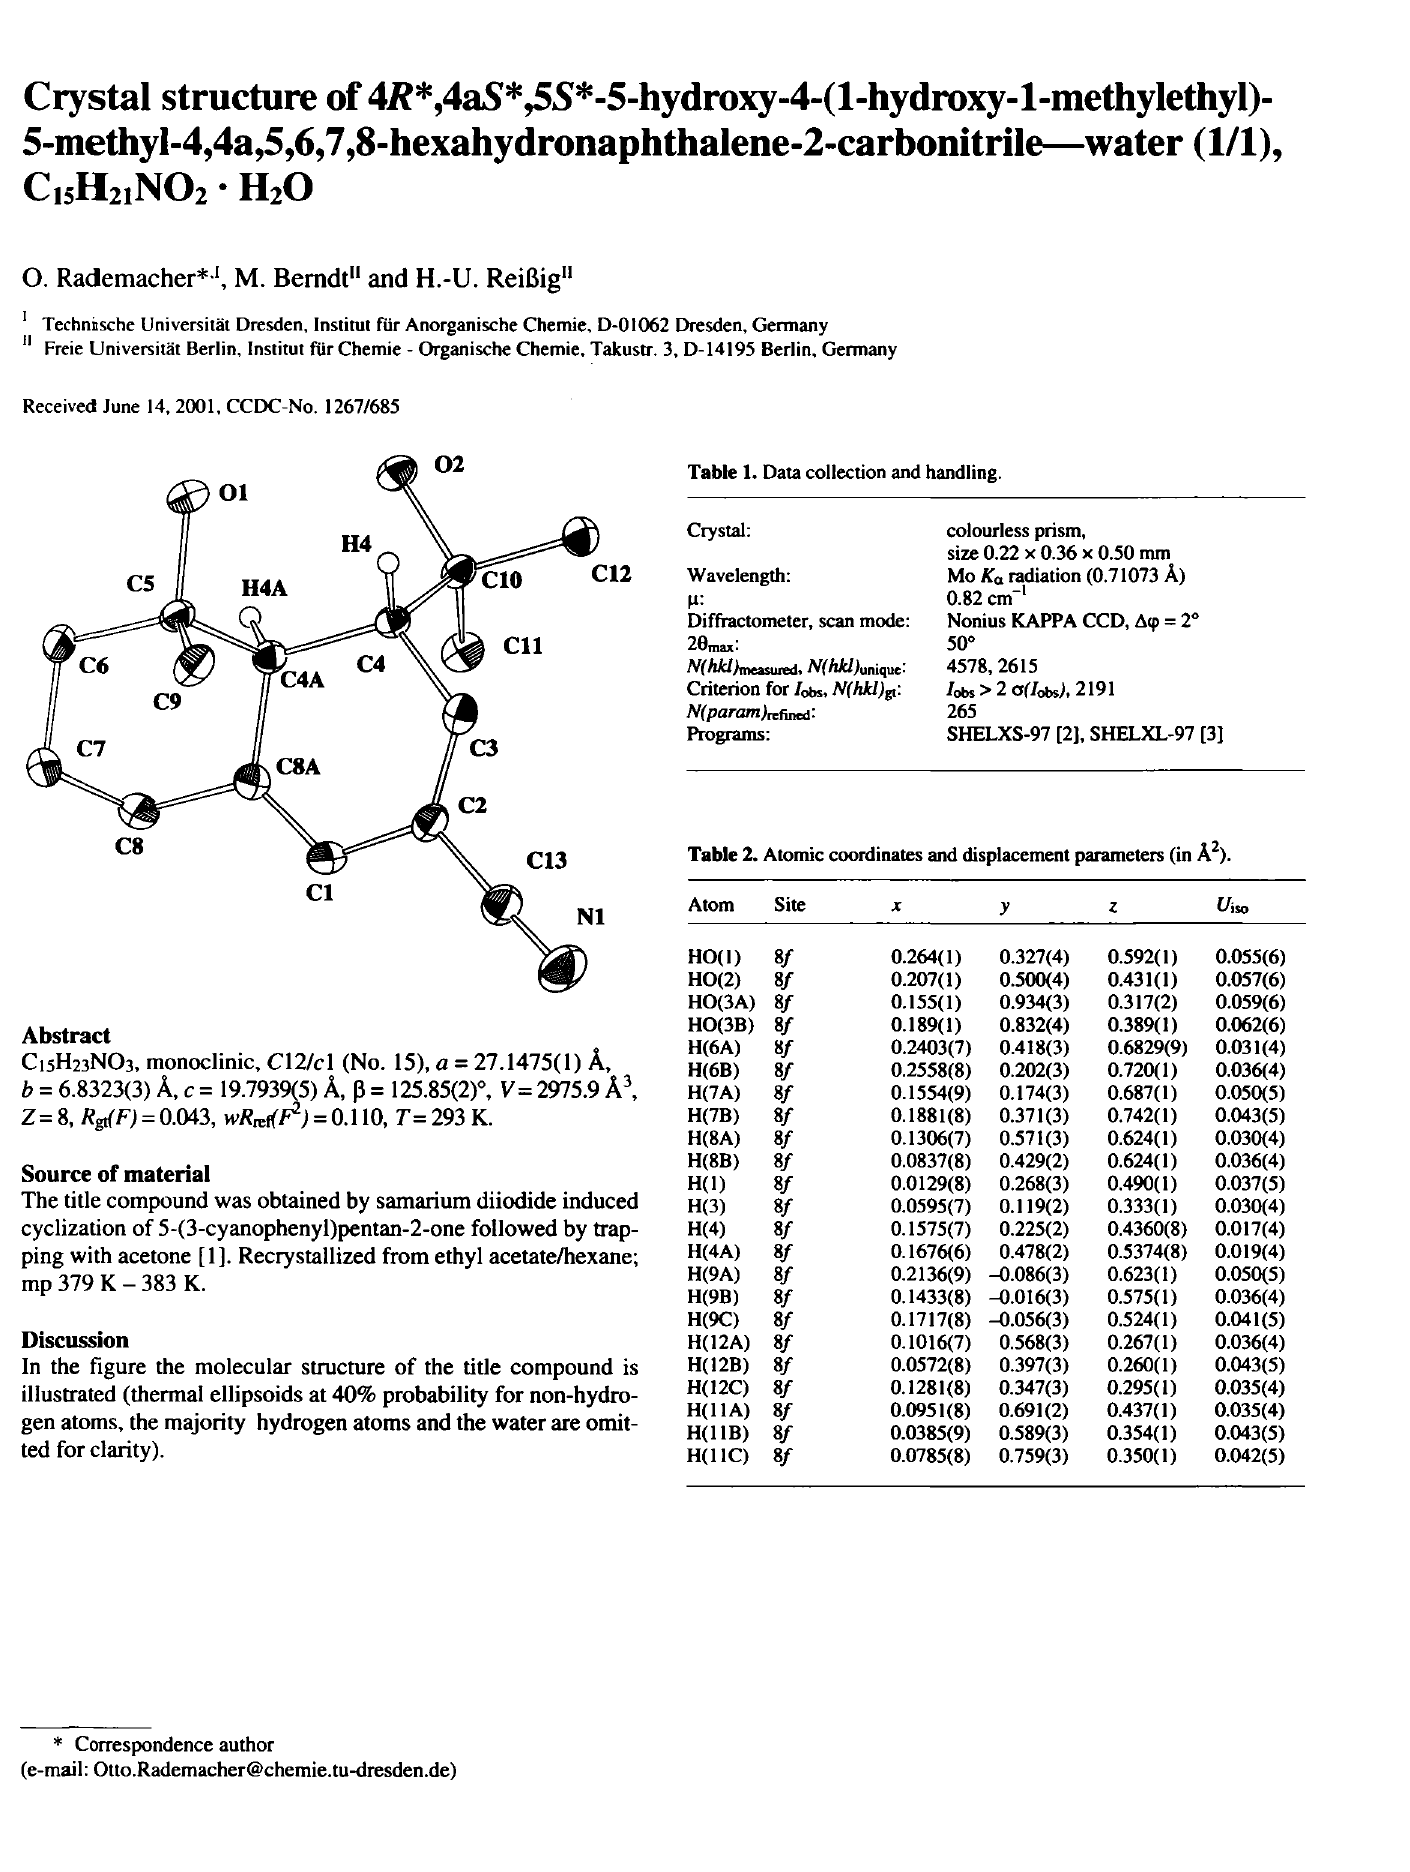
Table 1. Data collection and handling.